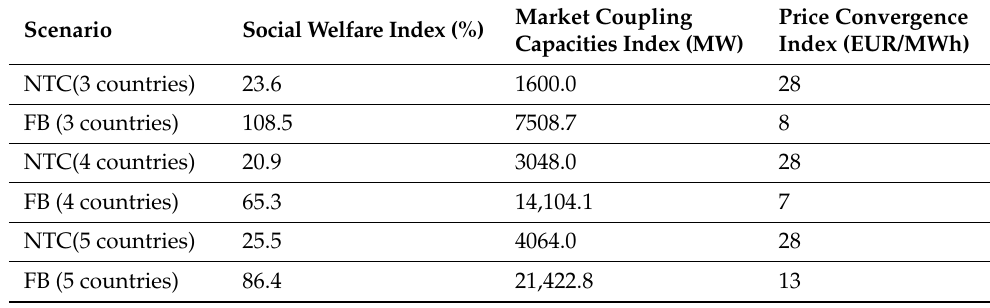
Table A2. Indexes for 5th of June.